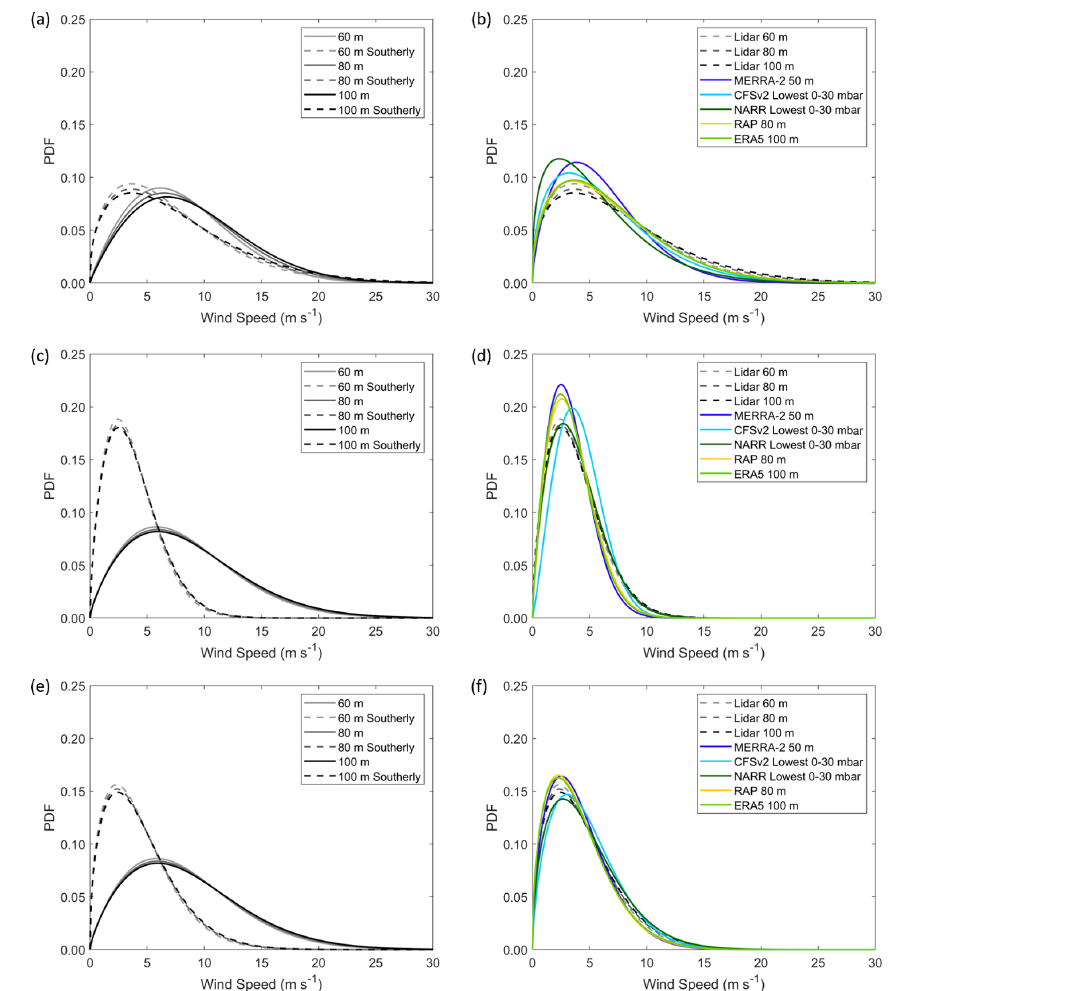
Figure 15. (a) Weibull fits to observed wind speeds for all wind directions (solid) and southerly flow (120–240 ◦ ) (dashed) at Humboldt. (b) Weibull fits to observed wind speeds for all wind directions (solid) and southeasterly flow (90–210 ◦ ) (dashed) at Morro Bay during (c) the overlapping Humboldt period and (e) the entire seasonal cycle. (b) Weibull fits to observed (dashed) and modeled (solid) wind speeds during southerly observed flow at Humboldt. Weibull fits to observed (dashed) and modeled (solid) wind speeds during southerly observed flow at Morro Bay during (d) the overlapping Humboldt period and (f) the full seasonal cycle,